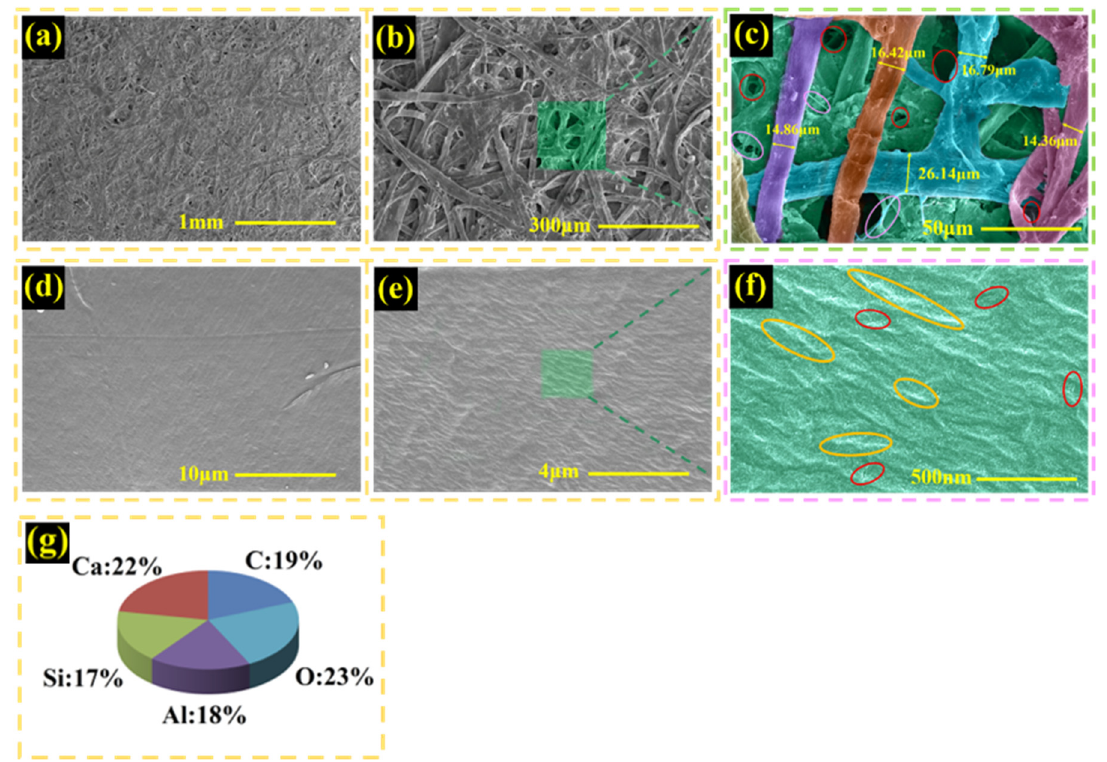
Figure 5. ( a – c ) SEM images of biodegradable paper film surface at different magnification; ( d – f ) SEM images of plastic white film surface at different magnification; ( g ) element content distribution on the surface of BM.